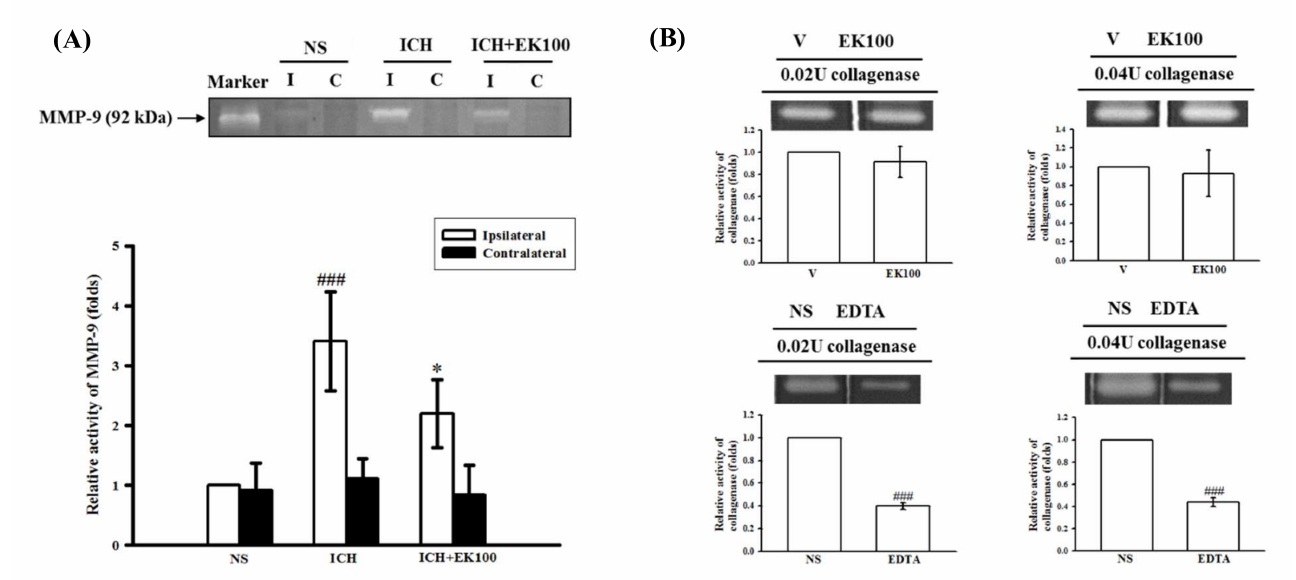
Figure 3. Effects of EK100 on the gelatinolytic activity of cerebral MMP-9 after ICH in vivo and collagenase VII enzyme in vitro. ( A ) C57BL/6 mice were administered EK100 with an oral dosage of 30 mg/kg at 30 min after the intrastriatal injection of 0.02 U collagenase to induce ICH. Brain slices (3 mm) were obtained at 24 h after ICH, and their brain tissue homogenates of ipsilateral (I) and contralateral (C) regions were evaluated for MMP-9 activity using zymography. The relative changes (folds) were represented as the mean ± SD ( n = 5). ### p < 0.001 compared with ipsilateral NS-intrastriatal injected with vehicle treatment group; * p < 0.05 compared with ipsilateral collagenase-intrastriatal injected with vehicle treatment group. The marker was represented as the positive control of MMP-9-mediated gelatinolysis from the medium of HT1080 cells. ( B ) The enzymatic units of collagenase VII (0.02 and 0.04 U) were used to evaluate the catalytic activity by gelatin zymography in vitro. EK100 (50 µ M) and its vehicle (V) or the positive control (EDTA, 2 mM) and its vehicle (NS) were added to the reacting buffer with the manipulated gels as described in the Methods section. The relative changes (folds) were represented as the mean ± SD. ### p < 0.001 compared with the vehicle-treated condition in